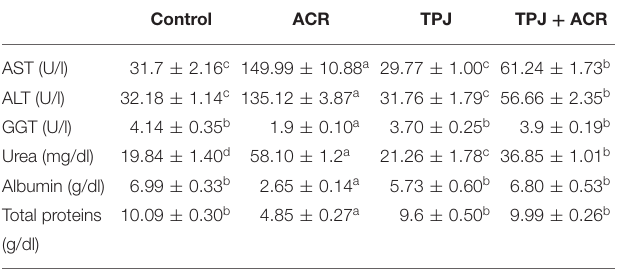
Values are expressed as means ± SE. Means in the same raw with different superscript indicate significant statistical differences at p < 0.05.